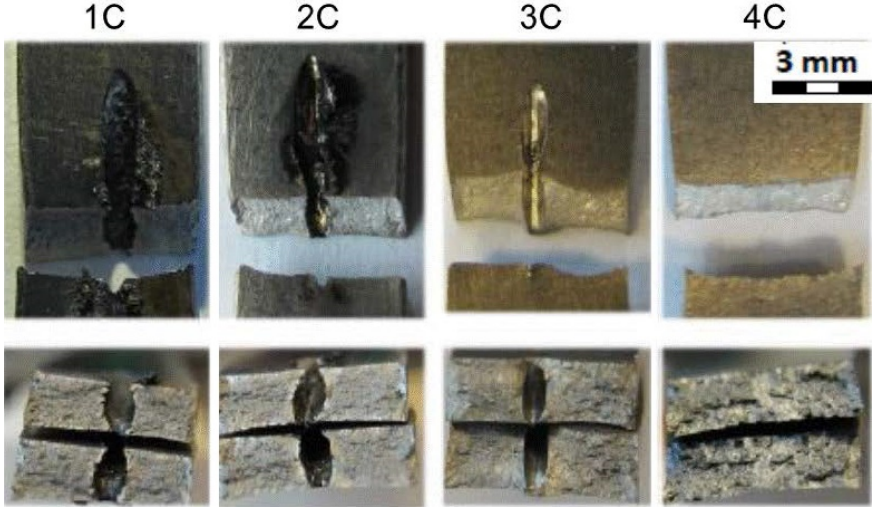
Table 8. Average values of mechanical properties—Inconel 718; material thickness 1.6 mm; tests at room temperature.